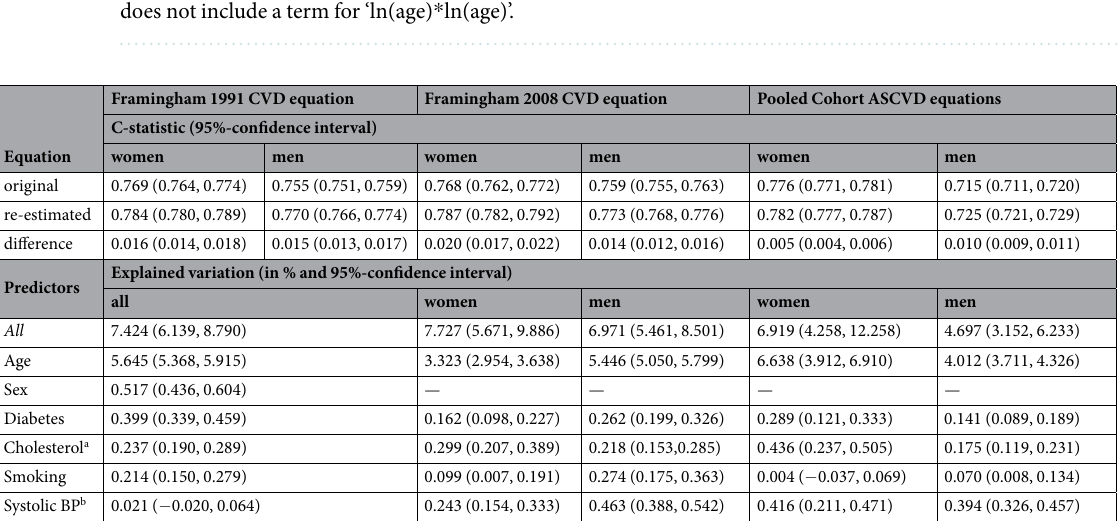
Table 2. C-statistics and explained variation for the five-year risk. Recalibrating an equation by updating the baseline risk does not change the original c-statistic. Explained variation is obtained from the re-estimated risk equations. For the Framingham 1991 CVD equation explained variation is estimated for all individuals, as women and men are modelled in one equation. Abbreviations: ASCVD, atherosclerotic cardiovascular disease; BP, blood pressure; CVD, cardiovascular disease. a Depending on the equation, the predictor cholesterol may include total and HDL cholesterol, and all interactions with these variables. For example, the PC equations include ln(total cholesterol), ln(HDL cholesterol), and the pair-wise interactions of the ln(age) with the ln(total cholesterol) and the ln(HDL cholesterol). b Depending on the risk equation, the predictor systolic BP includes systolic BP or untreated/treated systolic BP. For example, the Framingham 2008 equation includes ln(treated systolic BP), and ln(untreated systolic